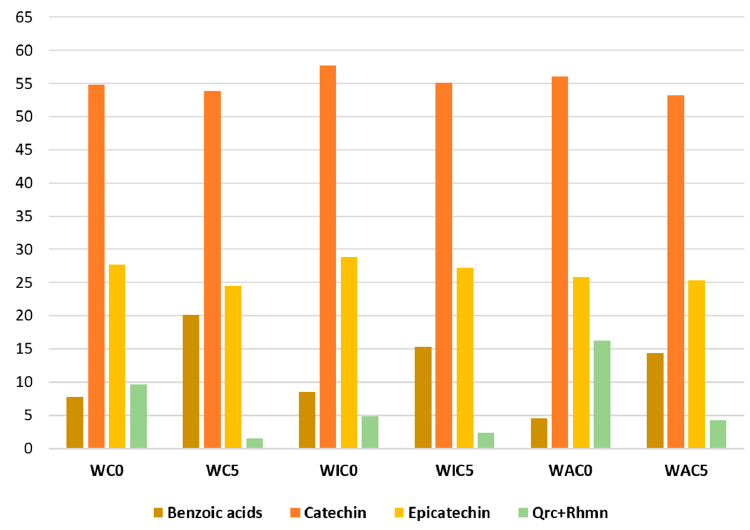
Figure 5. Histograms of percentage peak areas of benzoic acids (3,4-dihydroxybenzoic acid + 4- hydroxybenzoic acid + 3-hydroxybenzoic acid), catechin, epicatechin, quercetin + rhamnetin in yarns dyed with Acacia catechu ; samples are labelled according to the following code: W = wool, C = dyed with Acacia catechu , I = iron-mordant, A = aluminum mordant, 0 = unaged, 5 = aged for 500 h. A full list of the samples labels is provided in Table 3.